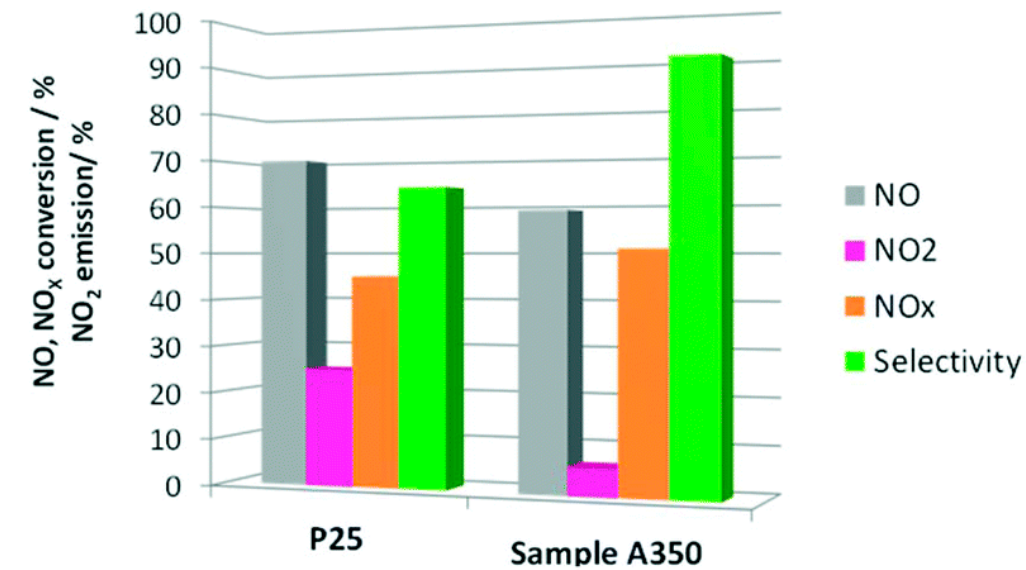
Figure 9. Mesocrystalline TiO 2 NPs are synthesized using a hydrothermal method as a photocatalyst for NOx abatement. The diagram reports NO conversion (%, grey), NO 2 released (%, pink), NOx conversion (%, orange) and selectivity values (%, green) for A350 Titania (“as prepared” sample) and P25 TiO 2 (as reference material) after five hours of light irradiation. The selectivity is here intended as the complete conversion of NO in nitrate or nitric acid, that leads to the e ffi cient removal of NOx species. In terms of NOx removal capability, the prepared titania appears to be a desirable photocatalyst, which combines high e ffi ciency in photochemical NO conversion (grey bar) and selectivity (green bar), resulting in the highest NOx conversion (orange bar). Reproduced with permission from